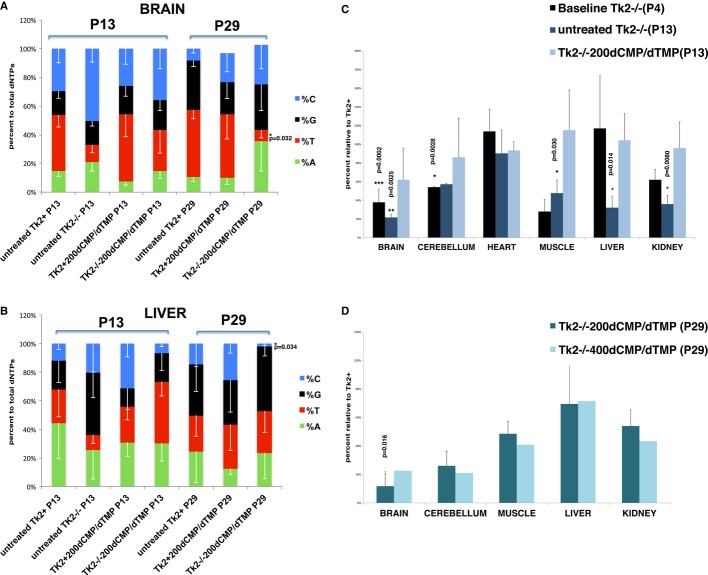
dCMP/dTMP effects on dNTP pool balance and mtDNA copy numberA, B   Proportions of dNTPs (in percents) in isolated mitochondria of brain (A) and liver (B) of 13 and 29 postnatal day mice (P13 and P29) demonstrate that levels of dTTP (red sections) were increased in treated mutant versus untreated mutant mice at P13, but were severely decreased in P29 Tk2−/−200dCMP/dTMP versus Tk2+200dCMP/dTMP (*P < 0.05; ***P < 0.0005; Mann–Whitney U-test).C   mtDNA copy numbers in mice reveal rescue of mtDNA depletion in all tissues of treated mutants at P13 (Tk2−/− versus Tk2−/−200dCMP/dTMP; *P < 0.05; **P < 0.005; ***P < 0.0005; Mann–Whitney U-test).D   Dose-related increase in mtDNA copy number in cerebral hemispheres of mutant mice at P29 (expressed as percent of untreated Tk2+ controls; mean ± SD; Tk2−/−200dCMP/dTMP versus Tk2−/−400dCMP/dTMP; *P < 0.05; Mann–Whitney U-test) (n = 5 for each group).Source data is available online for this figure.